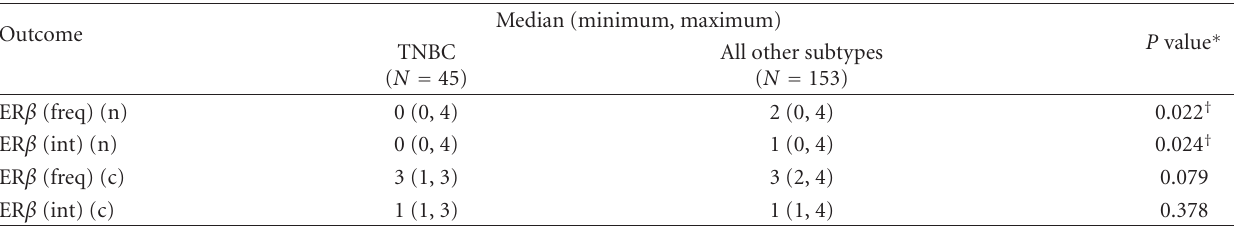
Table 6: Nuclear ER β expression is lower in triple-negative